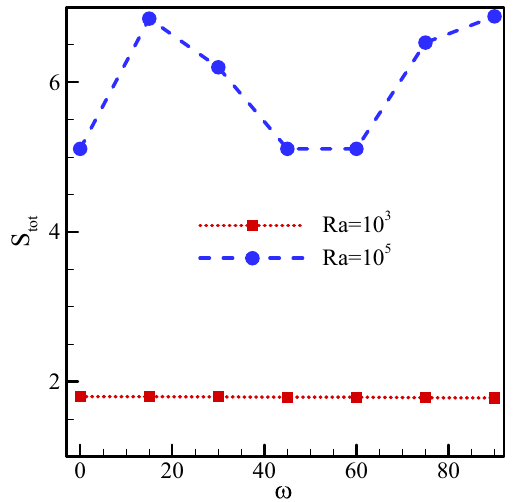
Figure 7. Total entropy generated for Ha = 20, Rd = 1, ϕ = 0.03, γ = 45 ◦ and various Ra numbers and magnetic field